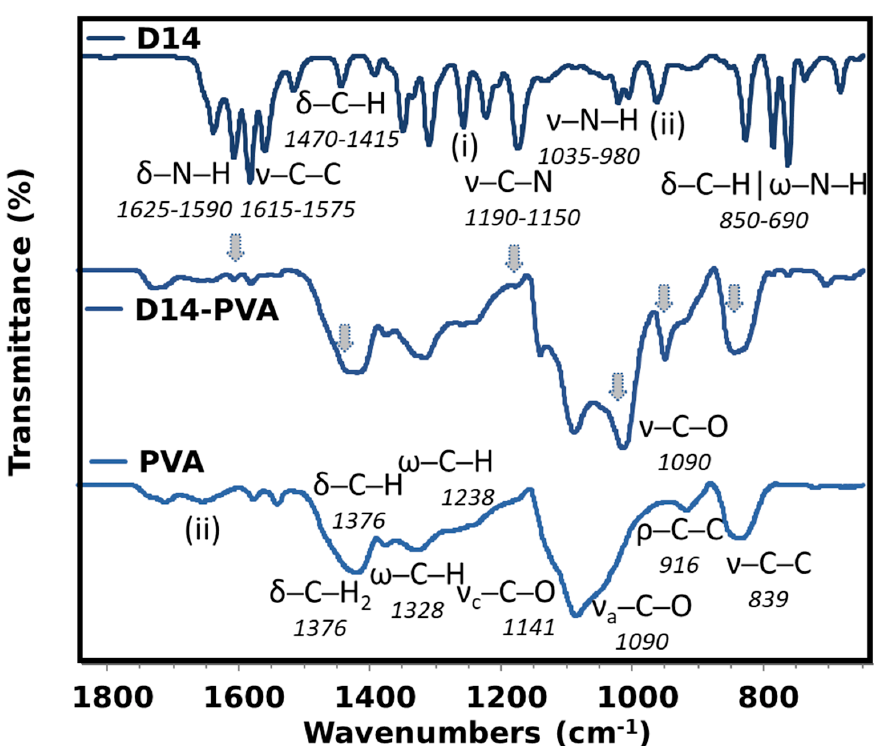
Polymers 2021 , 13 , x Figure A3. Detailed FTIR spectra of pure D14, PVA and the conjugated D14. Figure A3. Detailed FTIR spectra of pure D14, PVA and the conjugated D14.